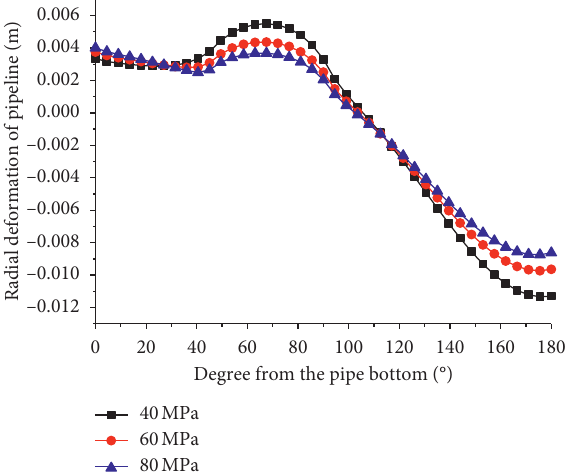
Figure 16: Radial deformation at different soil elastic modulus.